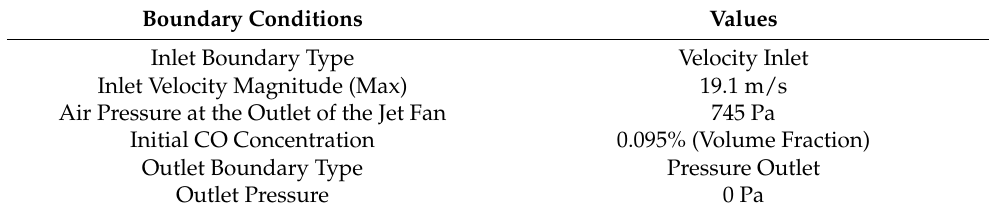
Table 12. Boundary conditions for Test 3.